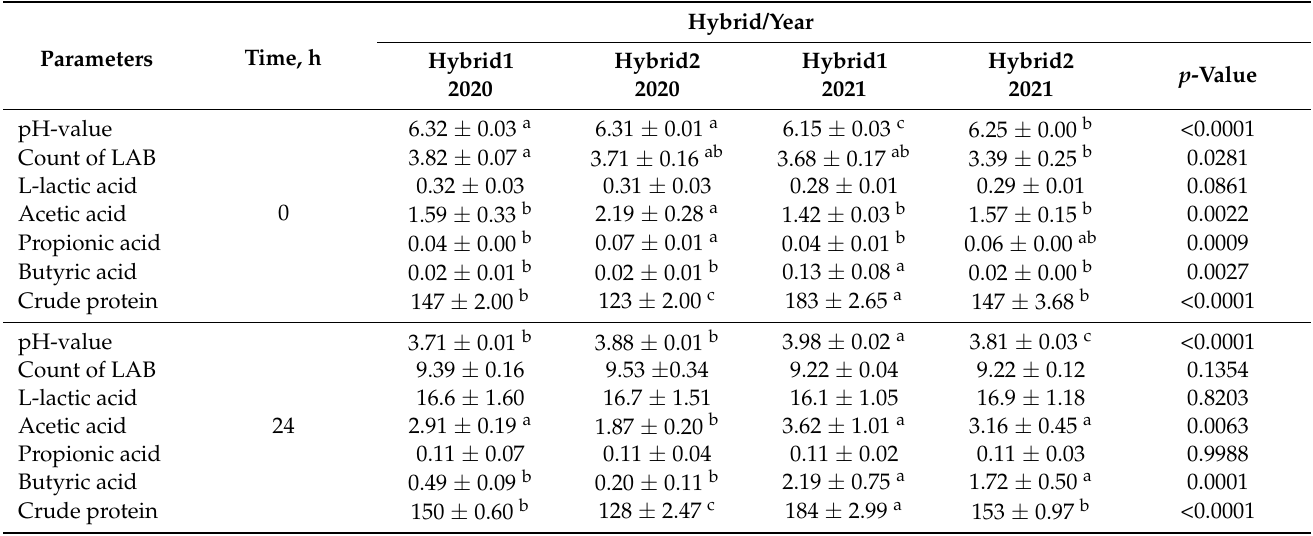
Table 4. pH values, count of lactic acid bacteria (LAB, log 10 CFU/g), L-lactic acid content (g/kg DM), SCFA concentrations (g/kg DM), and protein content (g/kg DM) in the fermented samples